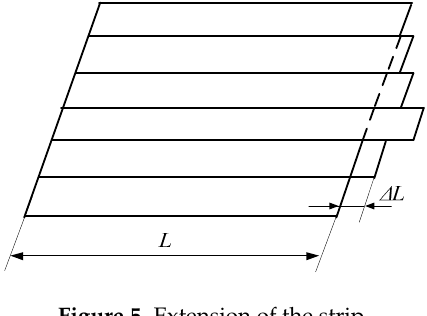
Figure 5. Extension of the strip.